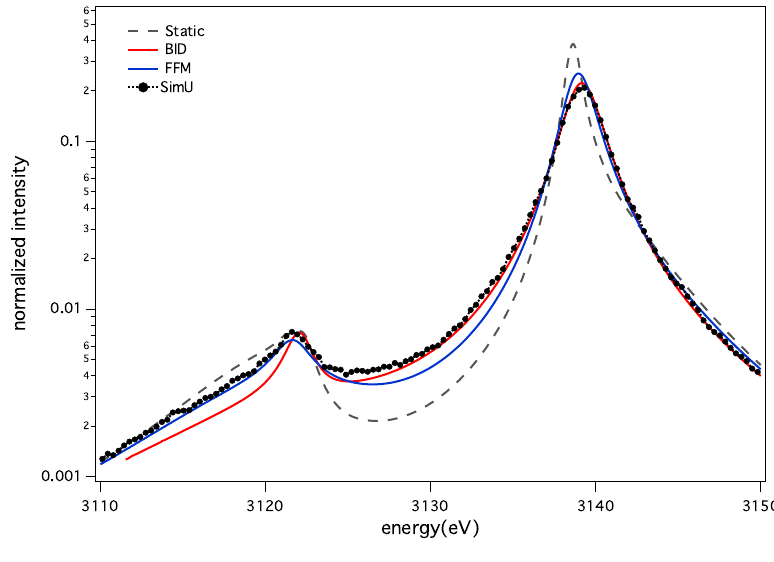
Figure 8. The He- (cid:11) line for T = 1 keV and n ion dynamics BID (solid red); FFM (solid blue); and SimU (black dot).